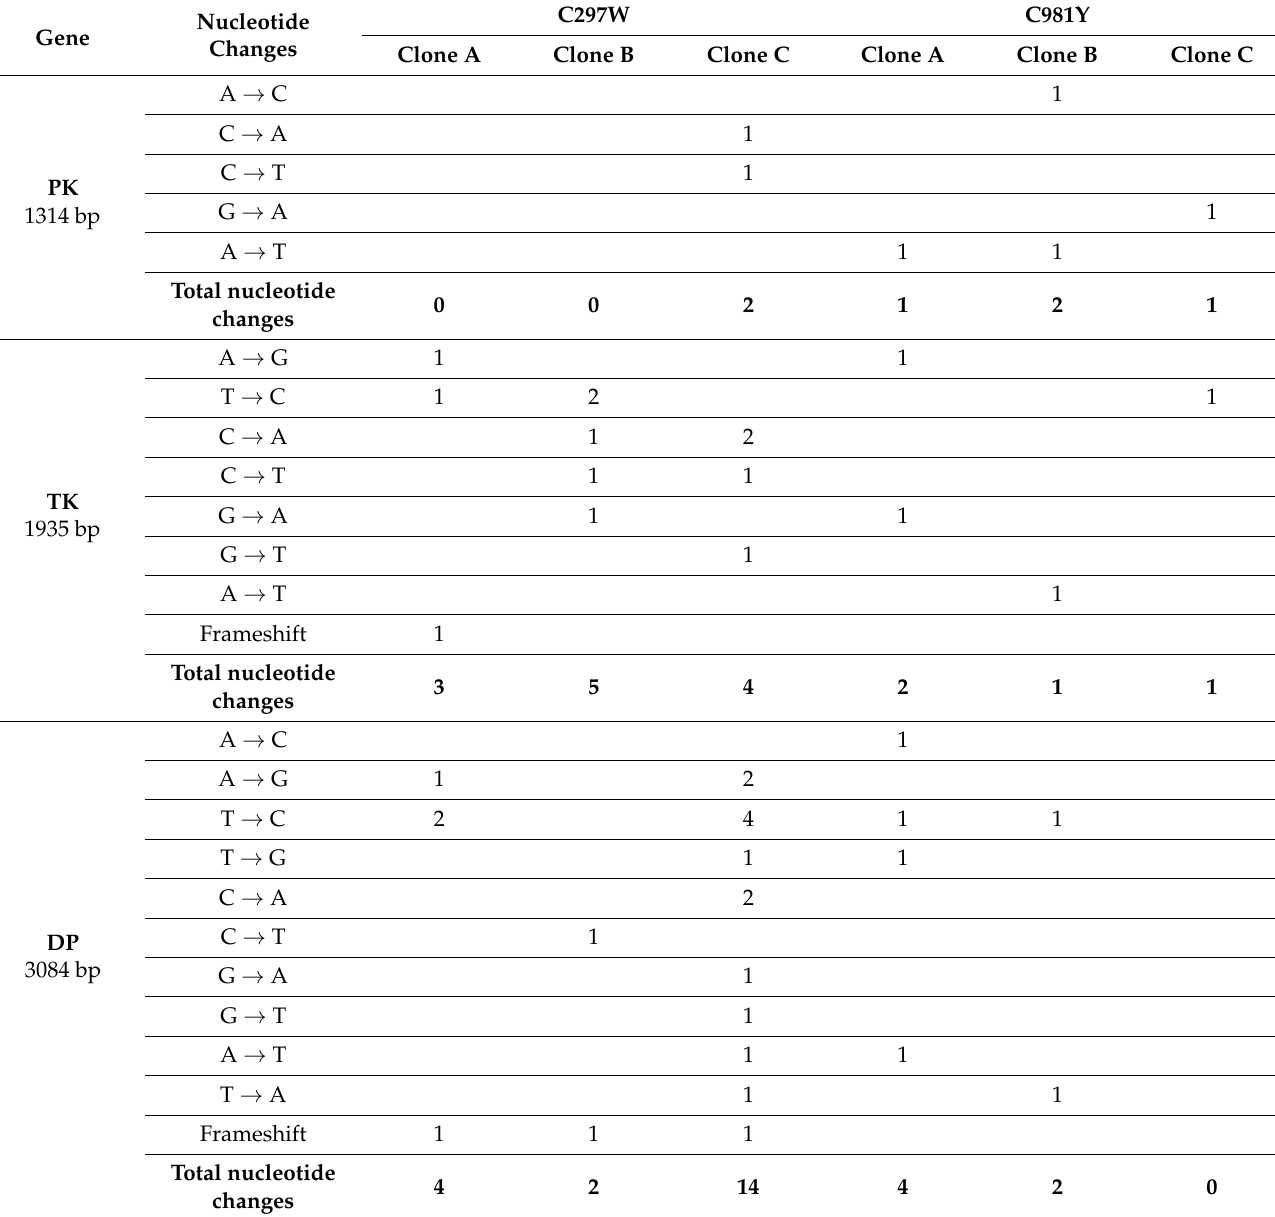
Table 1. Mutation frequency in the viral PK, TK and DP of mutator phenotype viral clones.